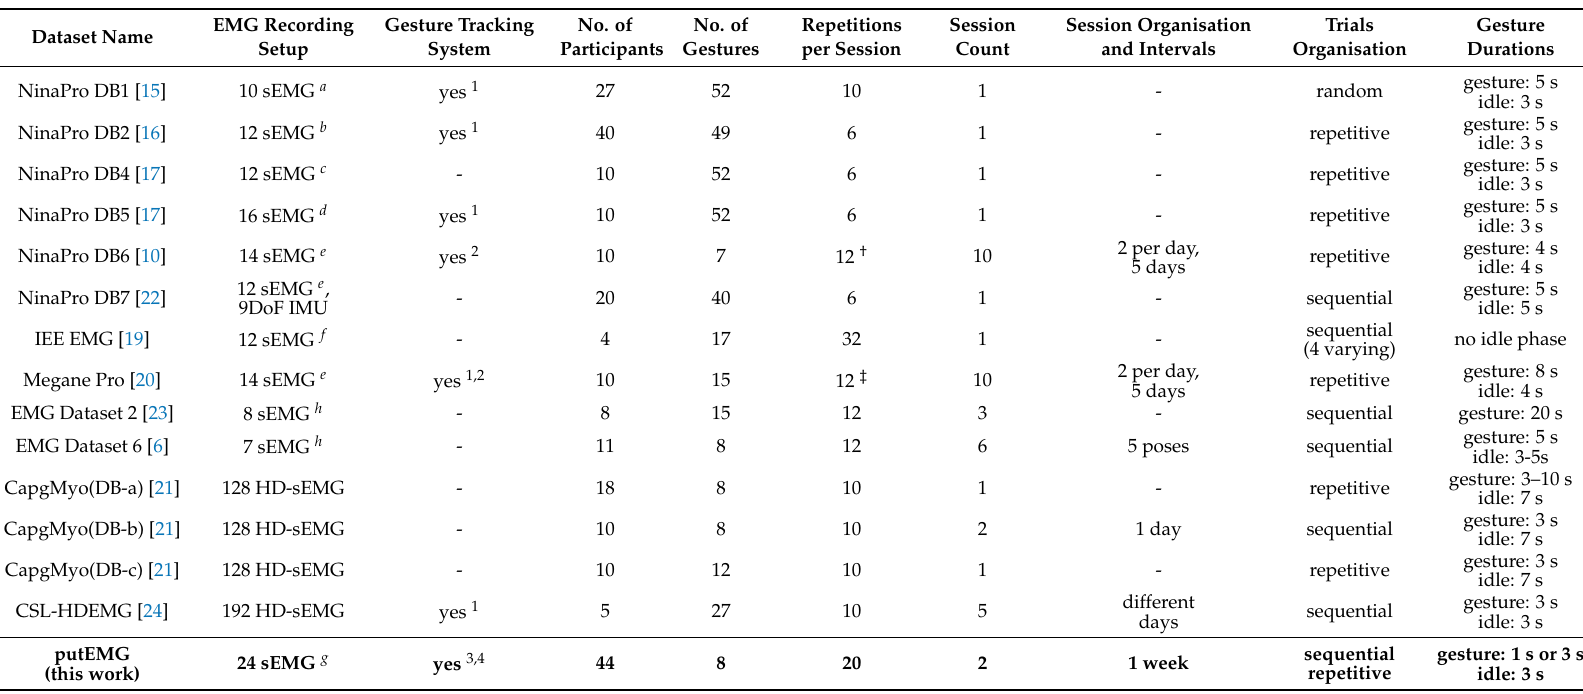
Table 1. A summary of publicly available sEMG datasets of hand gestures; the list only contains records for able-bodied subjects; biosignal recording systems: a OttoBock, b Delsys, c Cometa, d Thalmic Labs Myo, e Delsys Trigno, f EMG System do Brasil, g OT Bioelettronica MEBA, h Delsys Bagnoli; gesture tracking